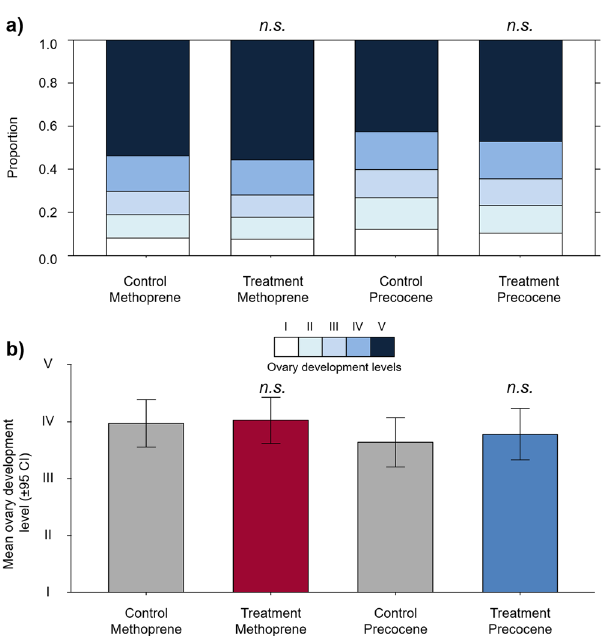
Figure 5. Juvenile hormone does not have a gonadotropic effect in workers. Treatment of workers with the JH analog methoprene or the JH inhibitor precocene-I did not affect rates of worker ovary development compared to their respective control when scored on a five point scale (I = undeveloped, V = fully developed) after a period of 13 days (panel a = stacked bar charts, panel b = mean ovary development and 95% confidence intervals shown on an ordinal scale, n.s. = non-significant differences based on an ordered logistic model, n = 40 workers per treatment